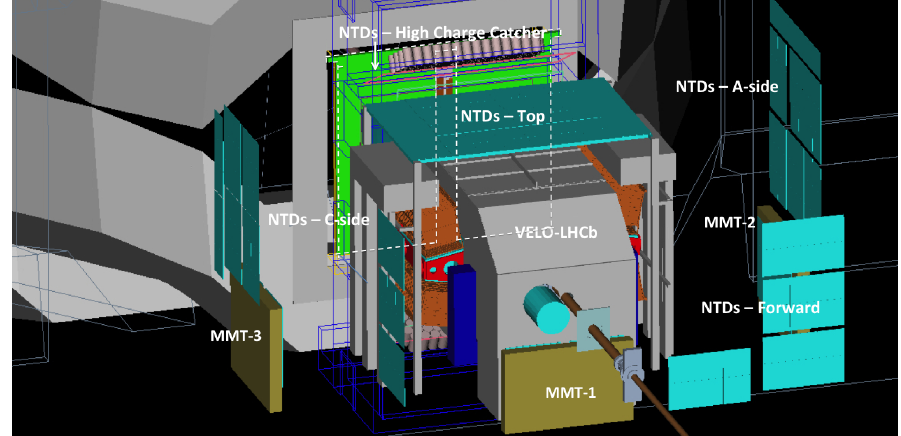
Figure 1. A visualization of the GEANT-4 simulation of the MoEDAL experiment, represented using Geant-4’s PANORAMIX